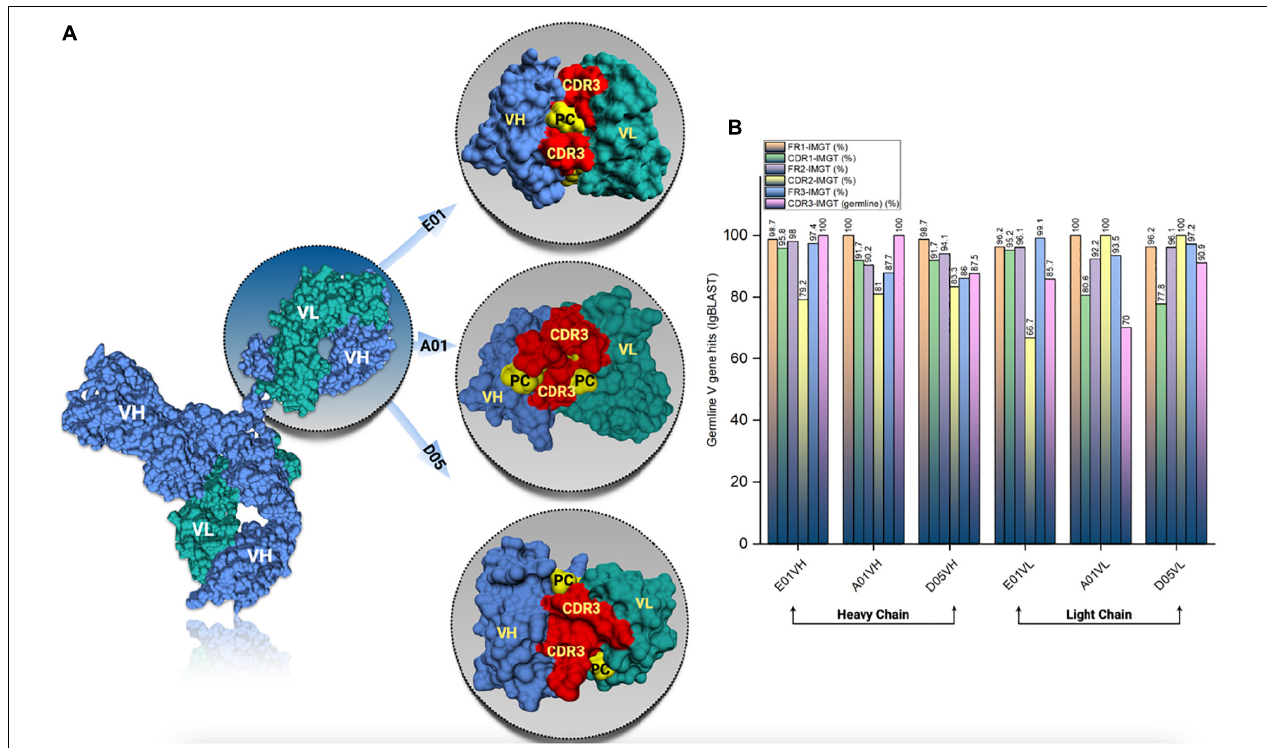
FIGURE 2 | Antibody structural modeling. (A) The structural representation of the modelled cloned antibodies from E01, A01 and D05 clones using SAbPred. (B) The frequency of germline V gene hits resulted from IgBLAST analysis.